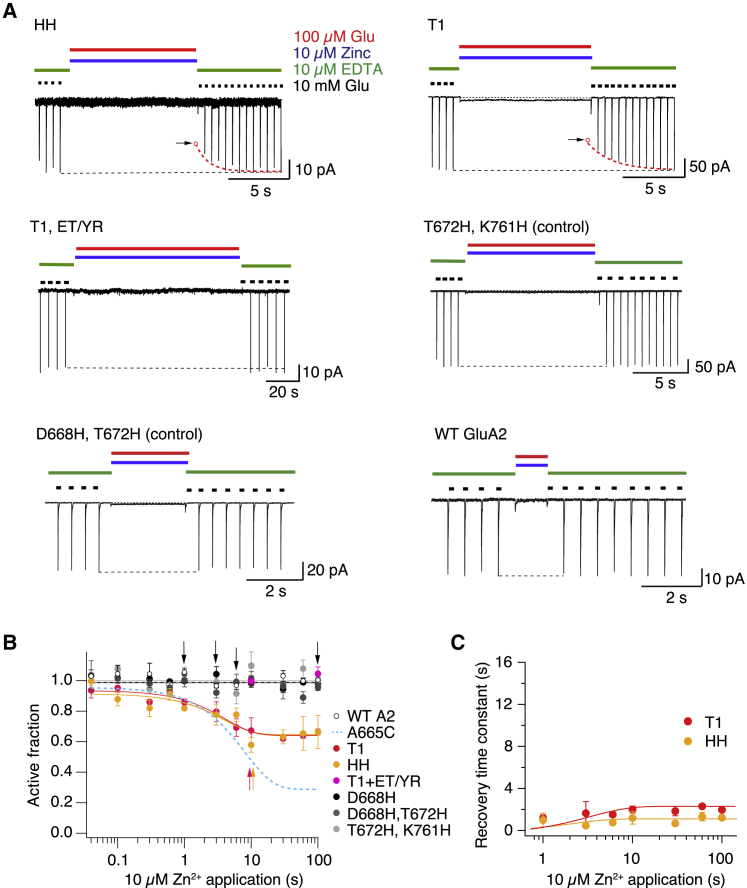
Lateral movements of the LBDs during desensitization. (A) Typical records for trapping and recovery from zinc trapping for the mutants HH (upper left panel) and T1 (upper right). Arrows indicate reduction of the current after trapping; dotted lines are double exponential fits to the recovery after trapping. The mutant T1 ET/YR shows no inhibition after 100-s exposure to zinc. Controls, such as the double mutants D668H and T672H and T672H and K761H, also showed no modification, behaving like WT GluA2. (B) The AF of receptors after Zn2+ exposure in the desensitized state (continuous lines are exponential fits) plotted against the interval. The probability of no difference (Student’s t-test) to the WT A2 (open circles) after 10 s of Zn2+ was 0.018 for T1 (red circles) and 0.001 for HH (yellow circles). Controls and T1 ET/YR were indistinguishable from WT A2. Arrows indicate intervals for the traces in A (n = 3–4 patches per point). (C) The time constants of recovery after Zn2+ trapping plotted against the trapping interval for T1 and HH (n = 3–4 patches per point). To see this figure in color, go online.